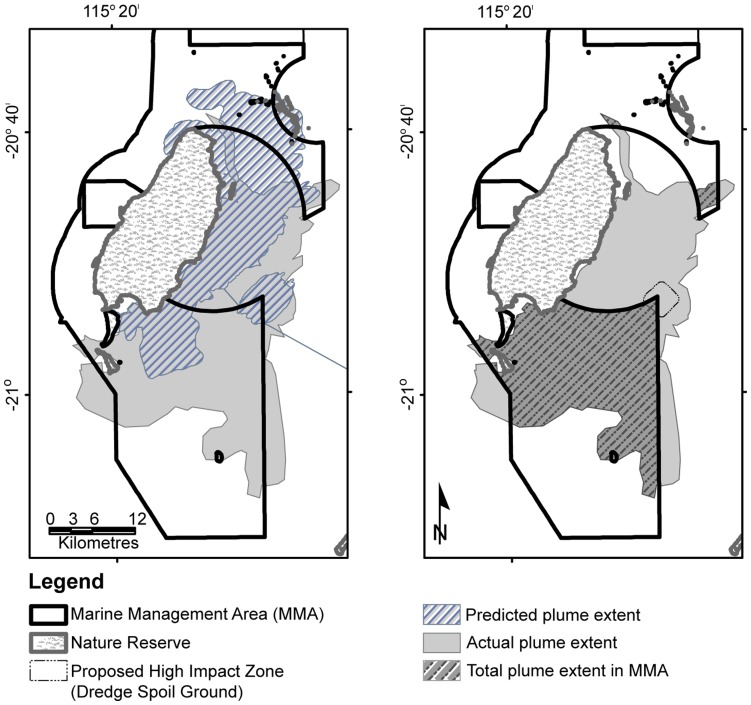
Map showing Montebello and Barrow Island Protected Areas, and a) the extent of the modelled plume and the actual dredge plume extent as defined by hand digitising MODIS images; and b) The overlap of the dredge plume into the Barrow Island Marine management area, over the duration of dredge period as defined by hand digitising MODIS images.